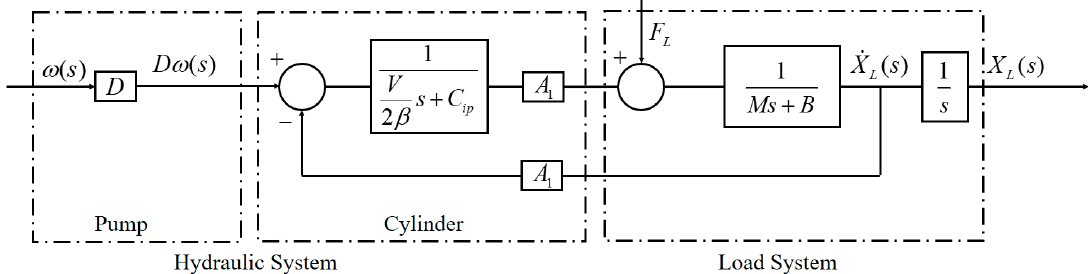
Figure 8. The block diagram of the entire system.